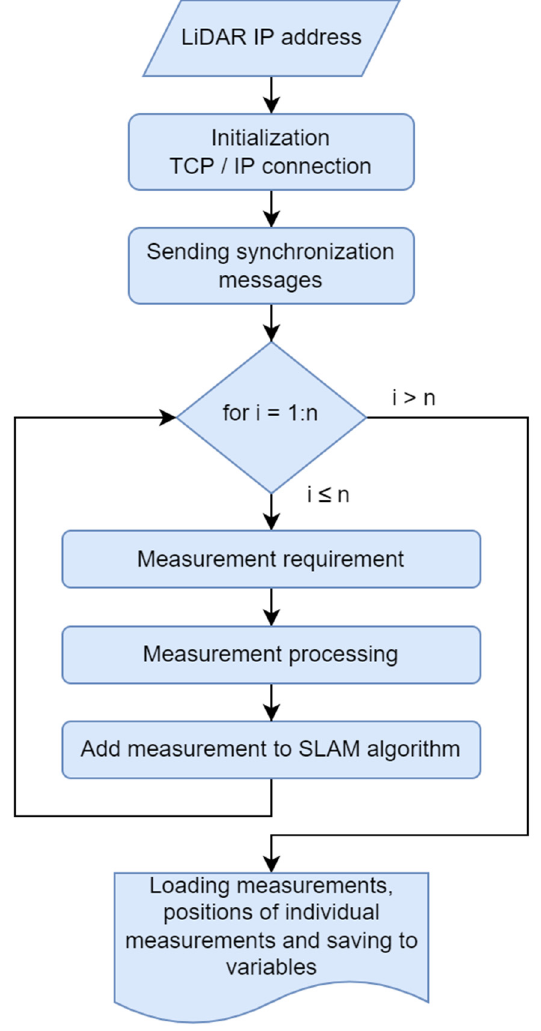
Figure 5. Flowchart of SLAM solution.